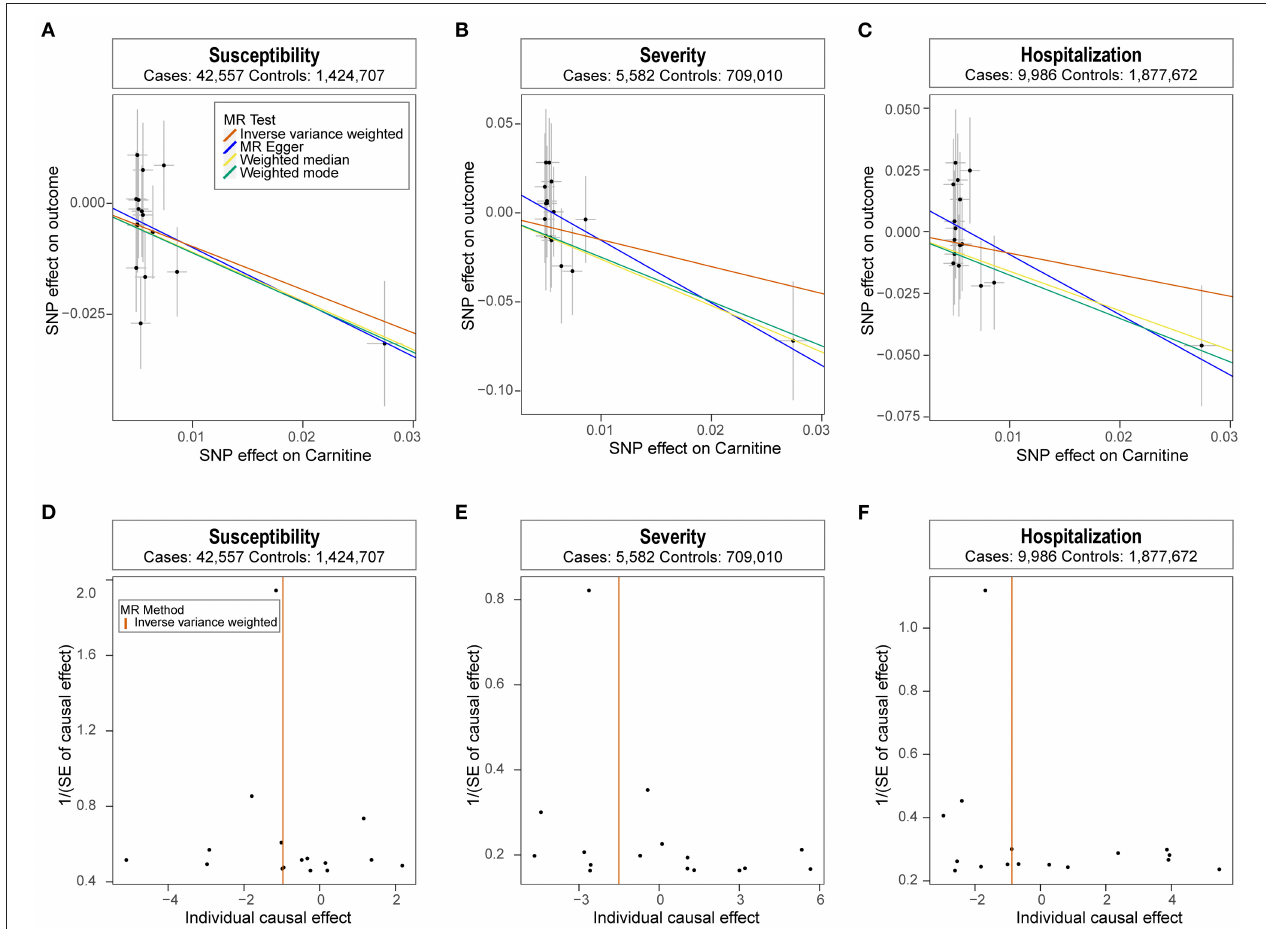
FIGURE 1 | Mendelian randomization analysis results. (A-C) Scatter plot of single nucleotide polymorphism (SNP) potential effects on carnitine level vs. COVID-19. The 95% CI for the effect size on COVID-19 is shown as vertical lines, while the 95% CI for the effect size on carnitine level is shown as horizontal lines. The slope of fitted lines represents the estimated Mendelian randomization (MR) effect per method. (D-F) Forest plot showing results from the Mendelian randomization analysis to evaluate potential causal associations between carnitine and COVID-19. Estimates are per 1 standard deviation (SD) increase in the trait.